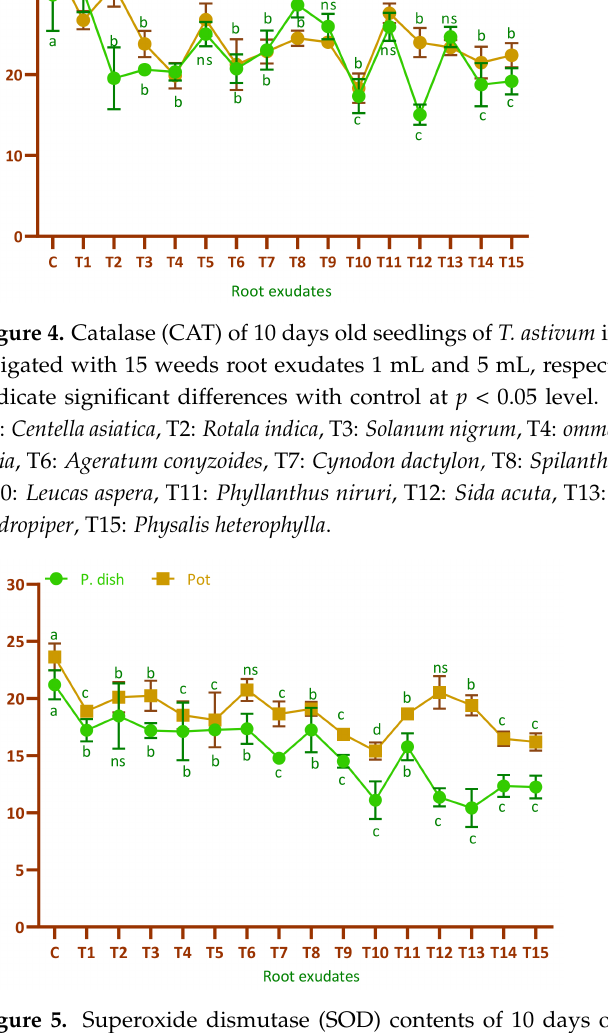
Figure 5. Superoxide dismutase (SOD) contents of 10 days old seedlings of T. astivum in Petri dishes and pot condition after irrigated with 15 weeds root exudates 1 mL and 5 mL, respectively. Different letters (a, b, c, and d) indicate significant differences with control at p < 0.05 levels. ns = not significant. C = Control, T1: Centella asiatica , T2: Rotala indica , T3: Solanum nigrum , T4: ommelina benghalensis , T5: Marsilea quadrifolia , T6: Ageratum conyzoides , T7: Cynodon dactylon, T8: Spilanthes acmella, T9: Heliotropium indicum, T10: Leucas aspera , T11: Phyllanthus niruri , T12: Sida acuta , T13: Mikania micrantha , T14: Polygonum hydropiper , T15: Physalis heterophylla